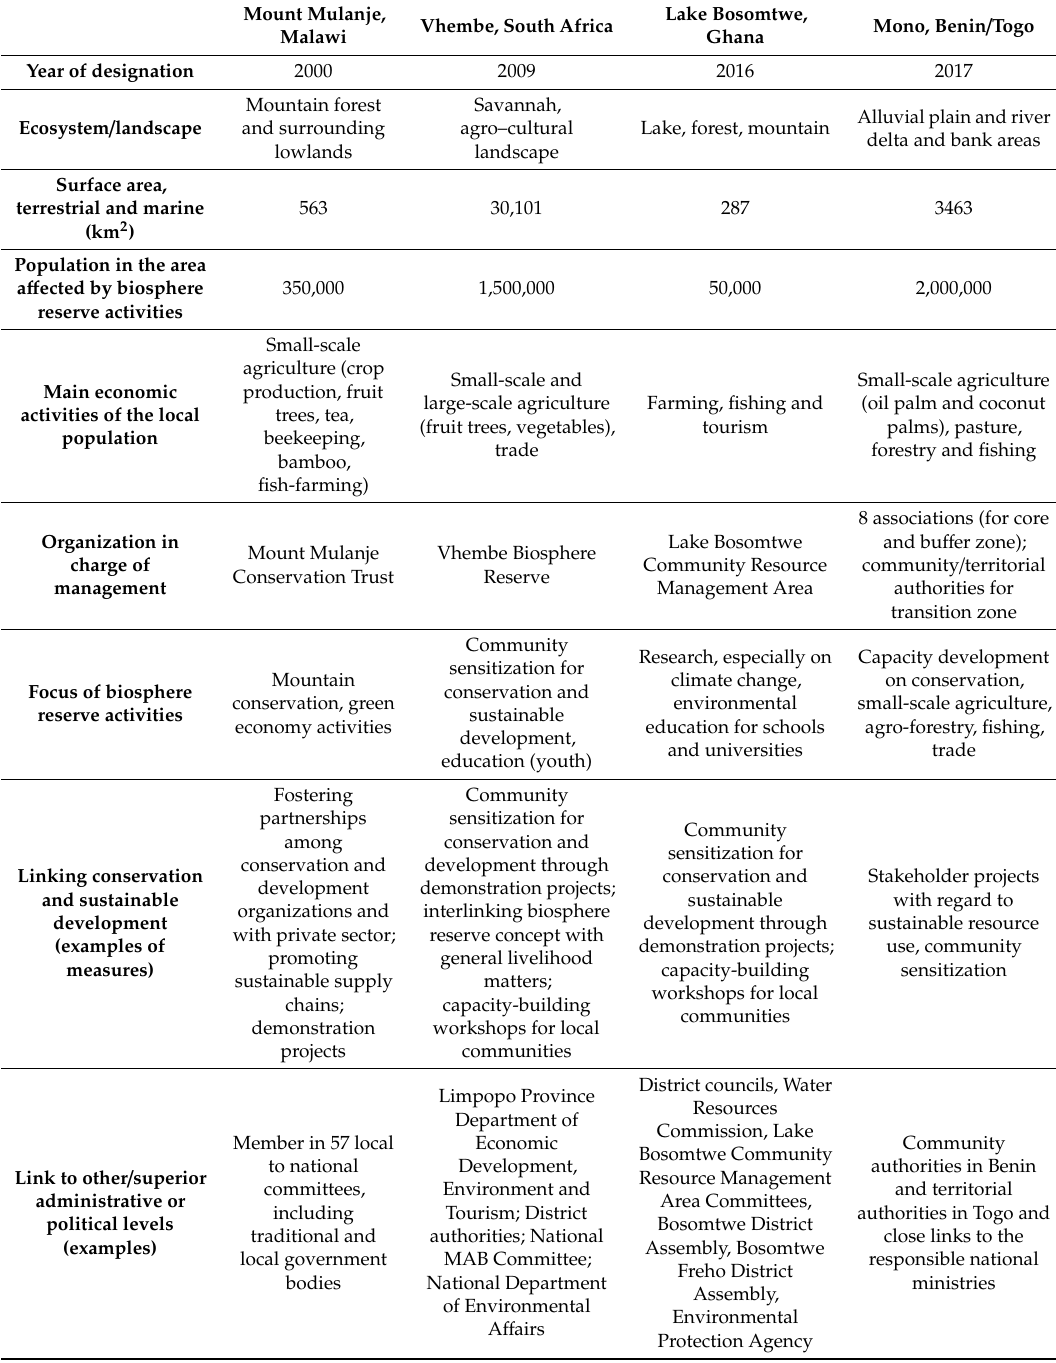
Table 1. Selected features of the investigated biosphere reserves. Source [46–51] and our own interviews